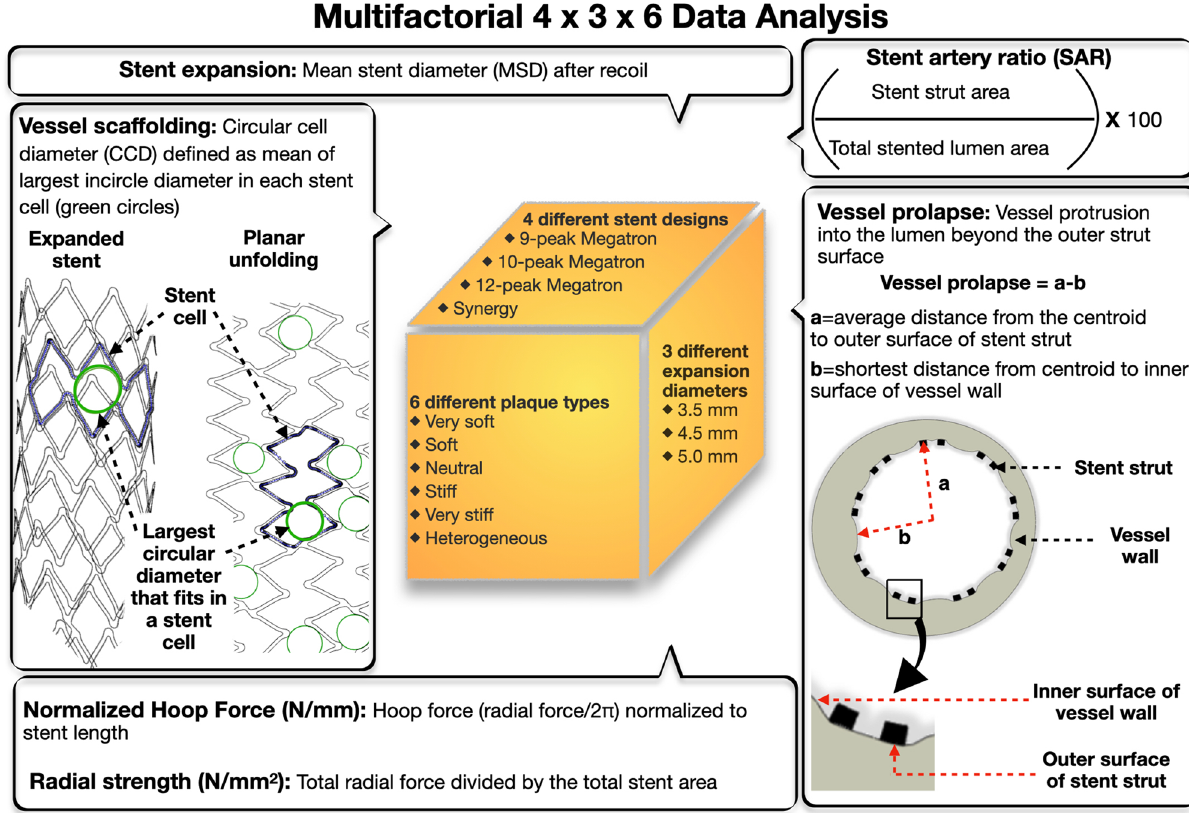
Figure 4. Design of computational analysis and definition of computational parameters. In our computational analyses, we factored 4 different stent designs, 3 stent expansion diameters and 6 plaque types in all n = 4 LM bifurcations. For each scenario, we calculated stent morphometric and biomechanical parameters i.e. stent expansion, vessel scaffolding, vessel prolapse, stent artery ratio, normalized hoop force, and radial ally expanded to 4.5 mm (inner diameter), then we applied radial crimping using multiple rigid plates to achieve a compressed diameter of 3.5 mm (inner diameter). The maximum hoop force by computational analysis was 7.7 N and by experimental analysis was 7.6 N (Supplemental Fig. 1). In addition to the normalized hoop force, we calculated directly the radial strength (N/mm 2 ) of stents expanded at 4.5 mm against heterogeneous plaque. The radial strength was calculated as the total radial force divided by the total stent area. Experimental bench studies. The scaffolding and normalized hoop force of the n = 4 stent designs were assessed experimentally by expanding the stents against soft hydrogel material and placing in a radial crimping machine, respectively. The experimental studies were performed in Boston Scientific Inc. (Maple Grove, MN, USA), independently from the computational studies by a different group of researchers, who were blind to the computational analysis findings. Scaffolding. Scaffolding was measured by an optical 360° scan of the stent geometry at each diameter of inter- est. The output of this scan allowed accurate measurements of the stent cell geometry. CCD was the measure used for assessment of scaffolding, as described in “Vessel Scaffolding” section. Normalized hoop force. The hoop force of the deployed stent was measured using a 12-element radial force gauge (Machine Solutions Incorporated, Flagstaff, AZ, USA; Supplemental Fig. 2), which applied uniform radial pressure on the stent until the stent achieved a pre-determined (15%) reduction in diameter. A 15% reduction in stent diameter was selected in order to capture the onset of permanent, non-recoverable, compressive diameter change. The maximum compressive hoop force required to achieve the prescribed reduction in diameter was normalized by the measured nominal stent length to generate a normalized hoop force value (N/mm). Statistical analysis. GraphPad Prism 8.0 (GraphPad Inc., San Diego, CA, USA) was used to perform all the statistical analysis. Continuous variables were expressed as mean with standard error of mean (SEM). The normality of the data distribution was assessed with the Kolmogorov–Smirnov test. Group comparisons were